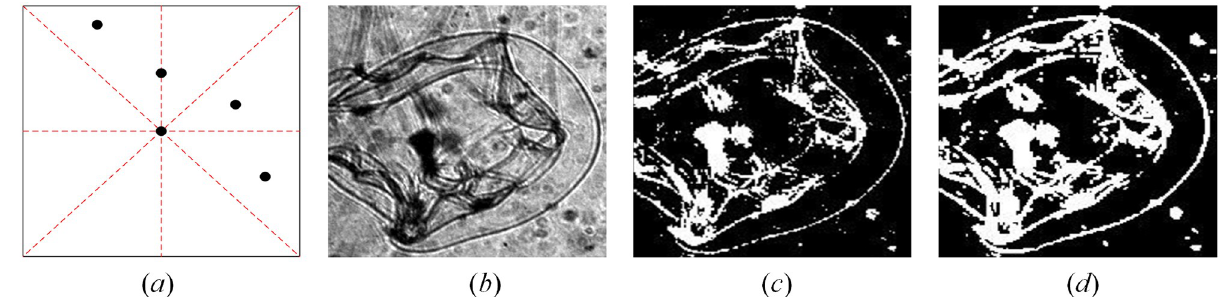
Fig 4. Enhancing target features. ( a ) Illustration of valid pixel. The black point in the center of the black rectangle is the pixel to be confirmed, and the 0.75 N valid pixels (other black points) around it lie within one of the rectangular windows or between two adjacent rectangular windows, so the valid central pixel is a part of the target; ( b ) Original ROI, the contrast of which is adjusted only for illustration purpose due to the heavy darkness of original ROI, and the procedure directly use the original ROI; ( c )Example from binarization with Sauvola’s method; ( d ) Example after enhancement with the edge roughening method.